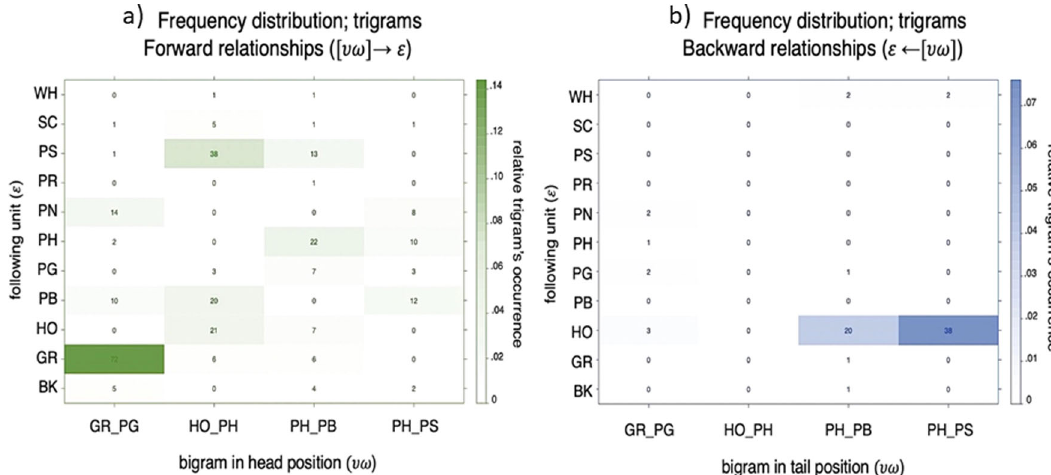
Fig. 5 Frequency distribution for bigrams within trigrams. a Bigrams occurring in head position ð υω Þ along the x axis and subsequent units ð ε Þ along the y axis. Color gradients (white-to-green) represent the relative occurrence of each bigram within the trigram ’ set. In each cell, the absolute frequency count for each three-unit sequence is also reported. b Frequency distribution for trigrams with bigrams occurring in tail position ð υω Þ along the x axis and preceding units ð ε Þ along the y axis. Color gradients (white-to-blue) represent the relative occurrence of each bigram within the trigram ’ set. In each cell, the absolute frequency count for each trigrams is also